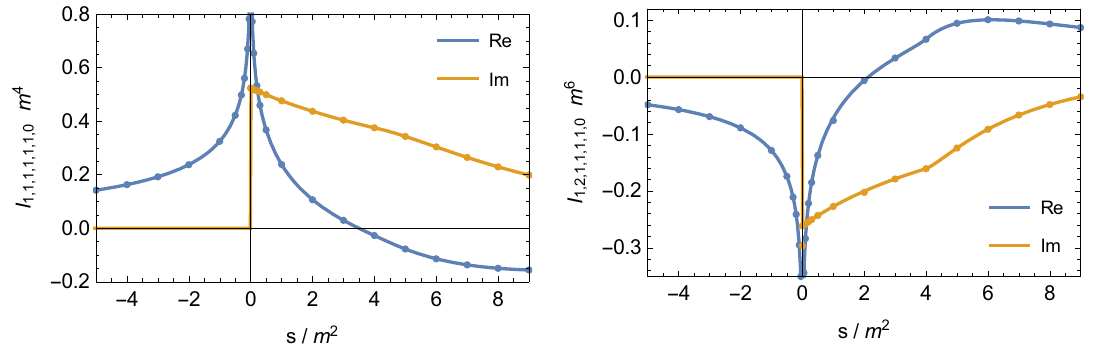
Figure 1 . Finite top-level master integrals m 4 I 1 ; 1 ; 1 ; 1 ; 1 ; 1 ; 0 (left) and m 6 I 1 ; 2 ; 1 ; 1 ; 1 ; 1 ; 0 (right). Solid curves were obtained with our representations, dots with SecDec